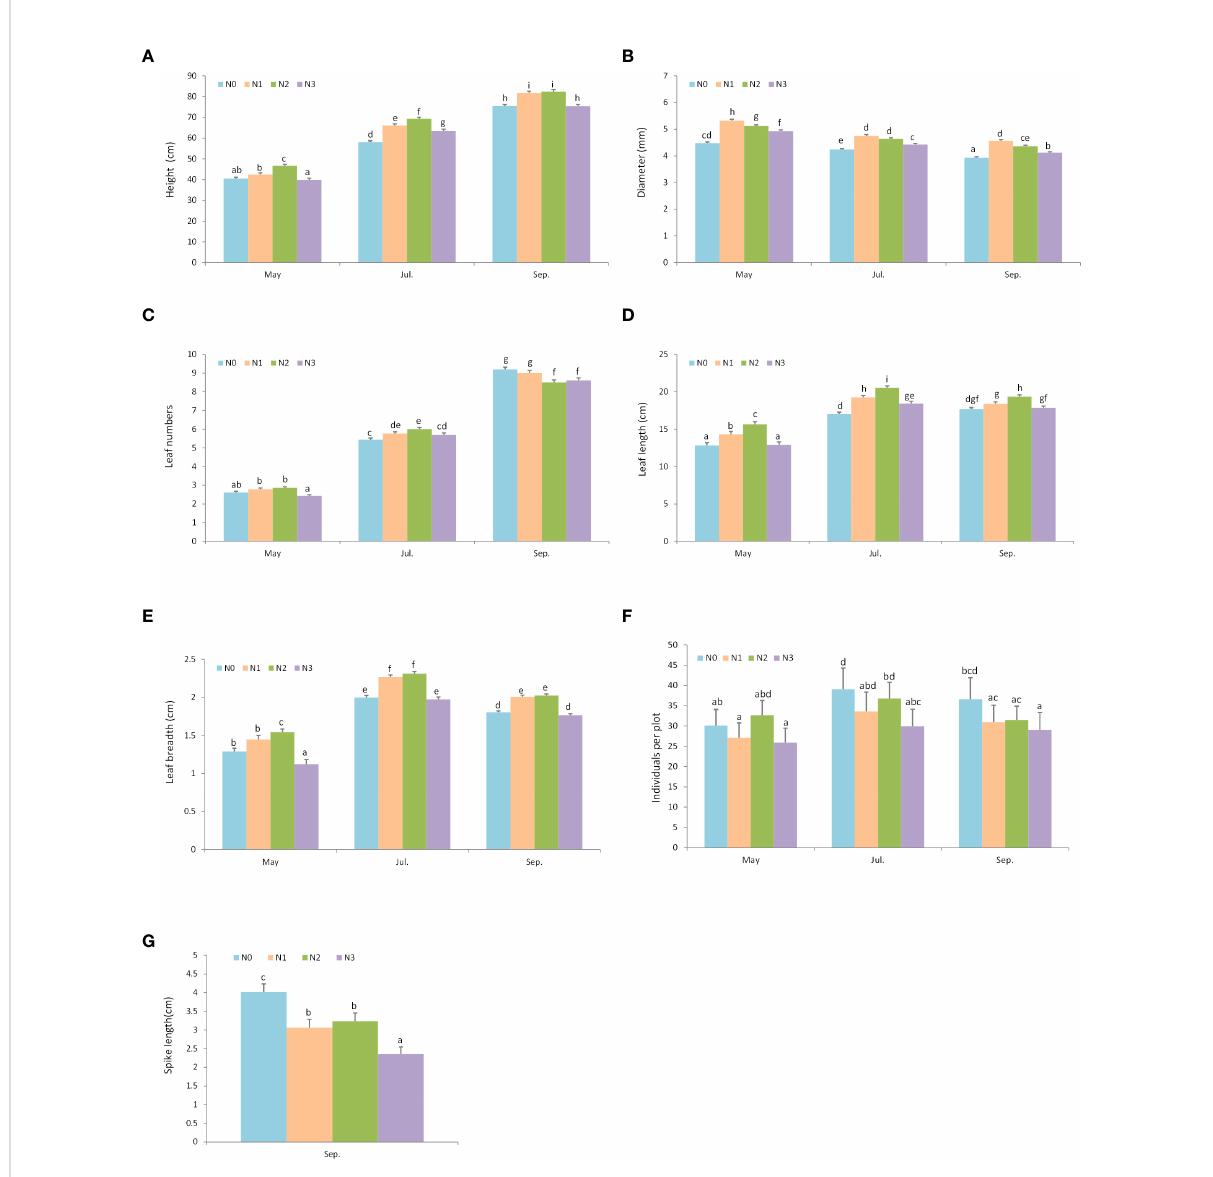
FIGURE 4 The effect of nitrogen addition on plant growth and reproductive traits in different months. Different letters denote statistically signi fi cant differences. N0: 0 g (cid:129) m -2 (cid:129) year -1 ; N1: 5 g (cid:129) m -2 (cid:129) year -1 ; N2: 20 g (cid:129) m -2 (cid:129) year -1 ; N3: 50 g (cid:129) m -2 (cid:129) year -1 . A : Height; B : Diameter (mm); C :Leaf numbers; D : Leaf length (cm); E : Leaf breadth (cm); F Individuals per plot; G : Spike length